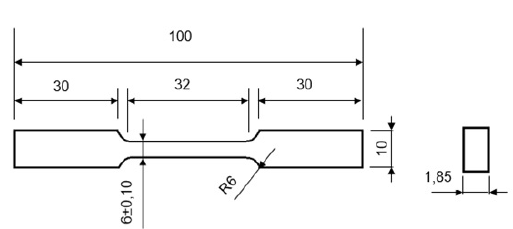
Figure 2. Specimen designed for tensile tests according to ASTM E8/E8M -09 4 .